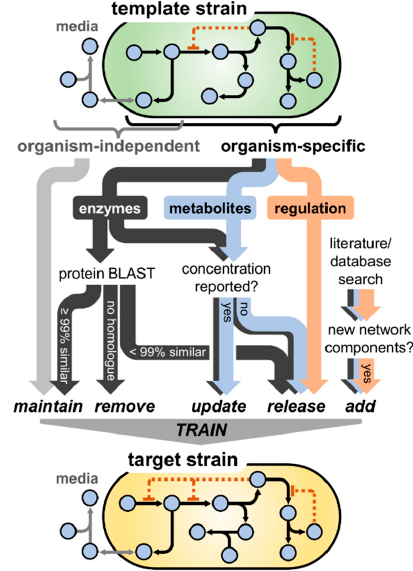
Figure 1. Schematic of the process of translating the NO ¨ stress model from one bacterial strain (“template strain”) to another (“target strain”). Beginning with the original model constructed for the template strain, model components were categorized as organism-independent (e.g., NO ¨ exchange with the gas phase) or organism-dependent (e.g., NO ¨ reductase activity). Although the extracellular (media) compartment contains a high frequency of organism-independent components, many are also present intracellularly (e.g., NO ¨ autoxidation). Parameters governing organism-independent processes were maintained at the same value, whereas those dependent on the species were handled differently depending on whether they governed enzyme activity, metabolite/biomolecule concentration, or transcriptional regulation. A BLAST analysis was conducted for each enzyme in the model, where parameters associated with enzymes exhibiting ě 99% amino acid similarity between the template and target strain were maintained at their original value, <99% similarity were released (allowed to vary) for subsequent training, and enzymes with no homologue in the target strain were removed entirely. If metabolite or enzyme concentrations were reported in the literature for the target strain, their values were updated in the model; however, if the concentrations had not been measured previously, they were released to be estimated during the training process. Given the relative complexity and large number of factors influencing the dynamics of transcriptional regulation, parameters governing these processes were released during model training. Finally, any additional network components (enzymes, metabolites, regulatory interactions) found in the literature to be involved in the NO ¨ stress network of the target organism that were not present in the original construction were added to the model. Upon finalizing the model structure, the unknown/released parameters were trained (optimized) on experimental measurements with the target organism (e.g., NO ¨ detoxification and respiratory O 2